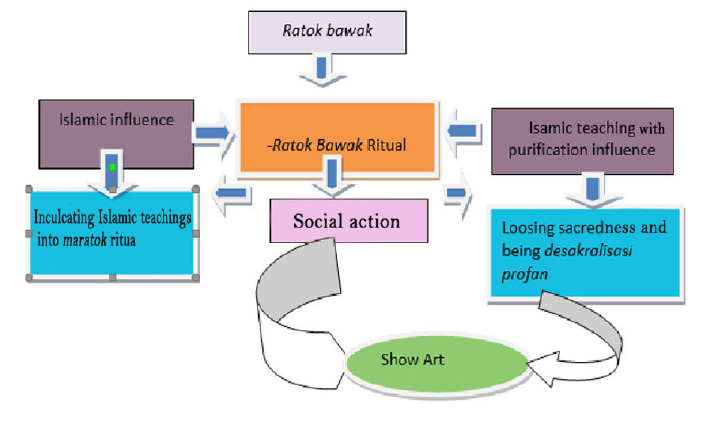
Figure 4. The existing structure of the ratok bawak ritual (source: created by